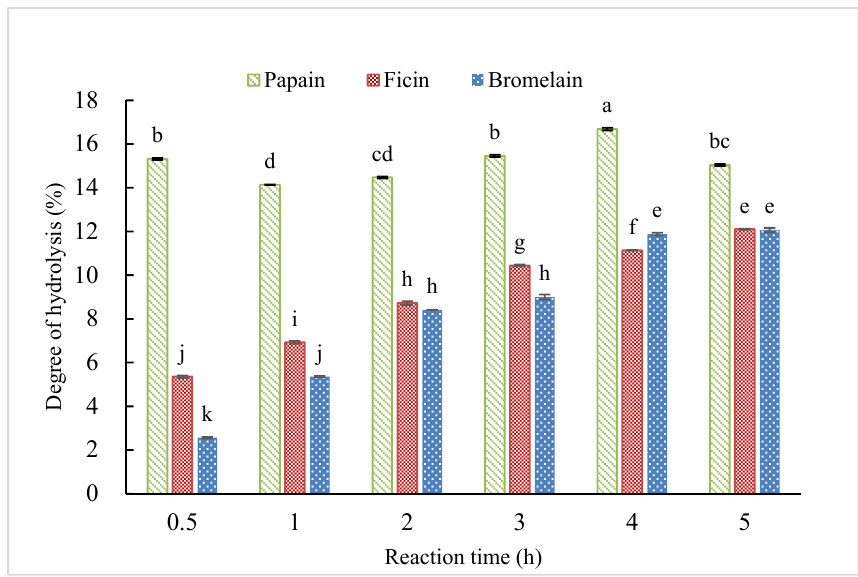
Figure 2. Degree of hydrolysis of CGM hydrolysates under different reaction times prepared by papain, ficin, and bromelain. (Different letters indicate significant differences at p < 0.05 for each enzyme). Total phenolic content and DPPH radical scavenging activity were used to evaluate the